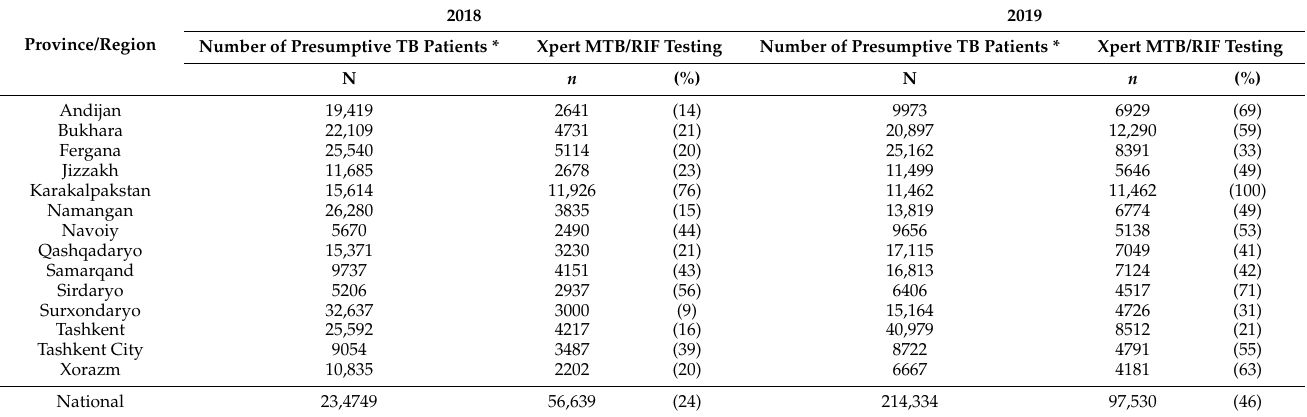
Table 2. Xpert MTB/RIF test coverage among presumptive tuberculosis (TB) patients visiting the health care facilities of Uzbekistan in 2018 and 2019